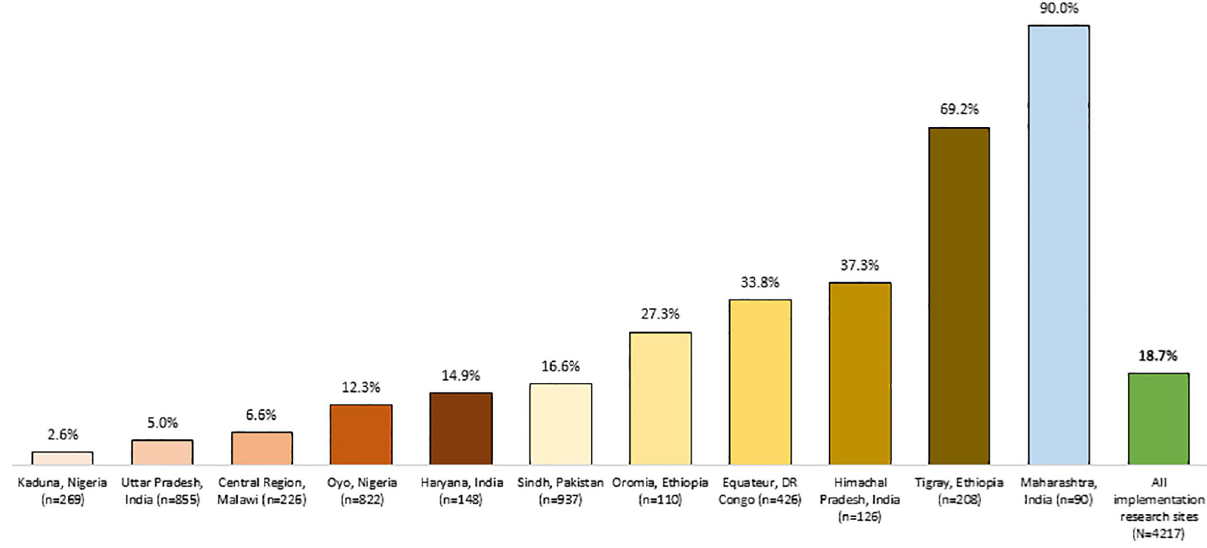
Fig 2. Acceptance of hospital referral among young infants with PSBI, by